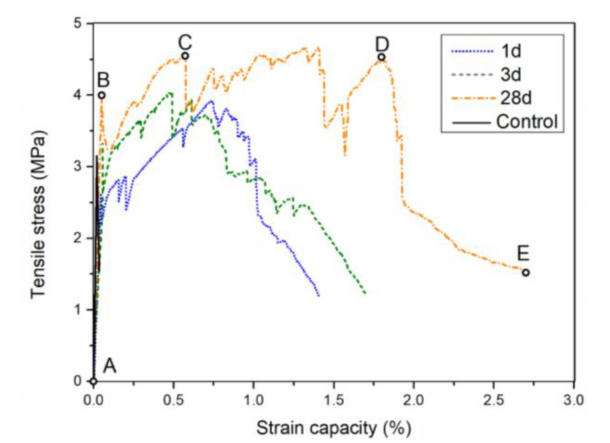
FIGURE 11 | Tensile stress-strain curves of the plain HB-CSA specimen (control) and CSA-ECC dog bone-shaped specimens after 1, 3, 28 days of curing.